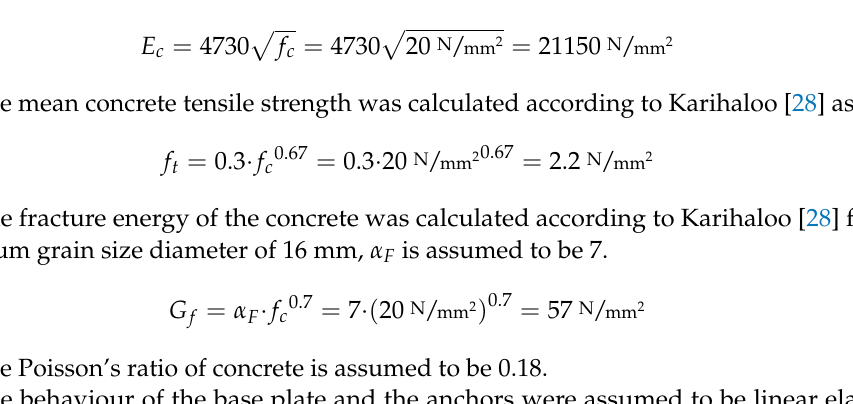
Figure 4. ( a ) 3D finite element model of GS-Tri-A, ( b ) base plate and anchos, ( c ) contact between anchor and concrete and contact between the base plate and concrete surface, ( d ) bond type bar elements along the anchor shaft and contact type bar elements below the base plate.